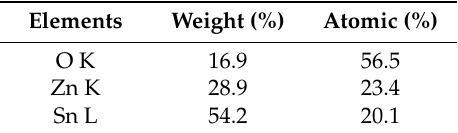
Table 1. Elemental contents of SnO 2 /ZnO 3D hetero-nanofibers.